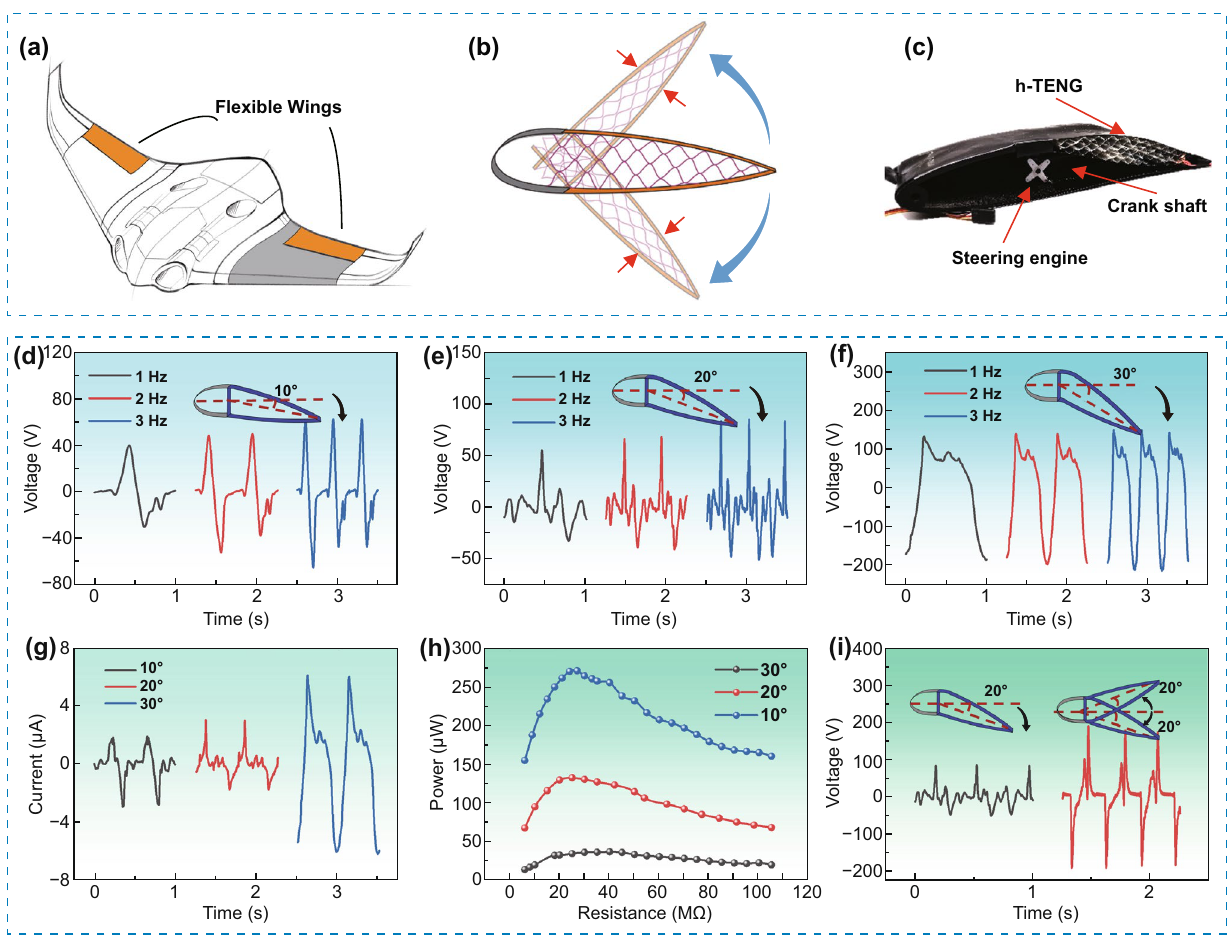
Fig. 6 a Morphing wing of the unmanned aerial vehicle (UAV). b A schematic view of the cross-section of the morphing wing, where honey- comb cellular mesostructure is replaced by light and compact h-TENGs skin. c A digital photograph of the fabricated morphing wing, which is controlled by a motor through non-conformal contact for adjusting the flap angle. d – f Output voltage waveforms of h-TENG at various excita- tion frequencies under different wing deflected angles of 10°, 20°, 30°. g Output currents of h-TENG with different wing deflected angles at a frequency of 2 Hz. h Output power comparisons of h-TENG with different wing deflected angles at a frequency of 2 Hz. i Comparisons of output power generation of morphing wings with unidirectional deflection and bidirectional motion at an excitation frequency of 3 Hz and a